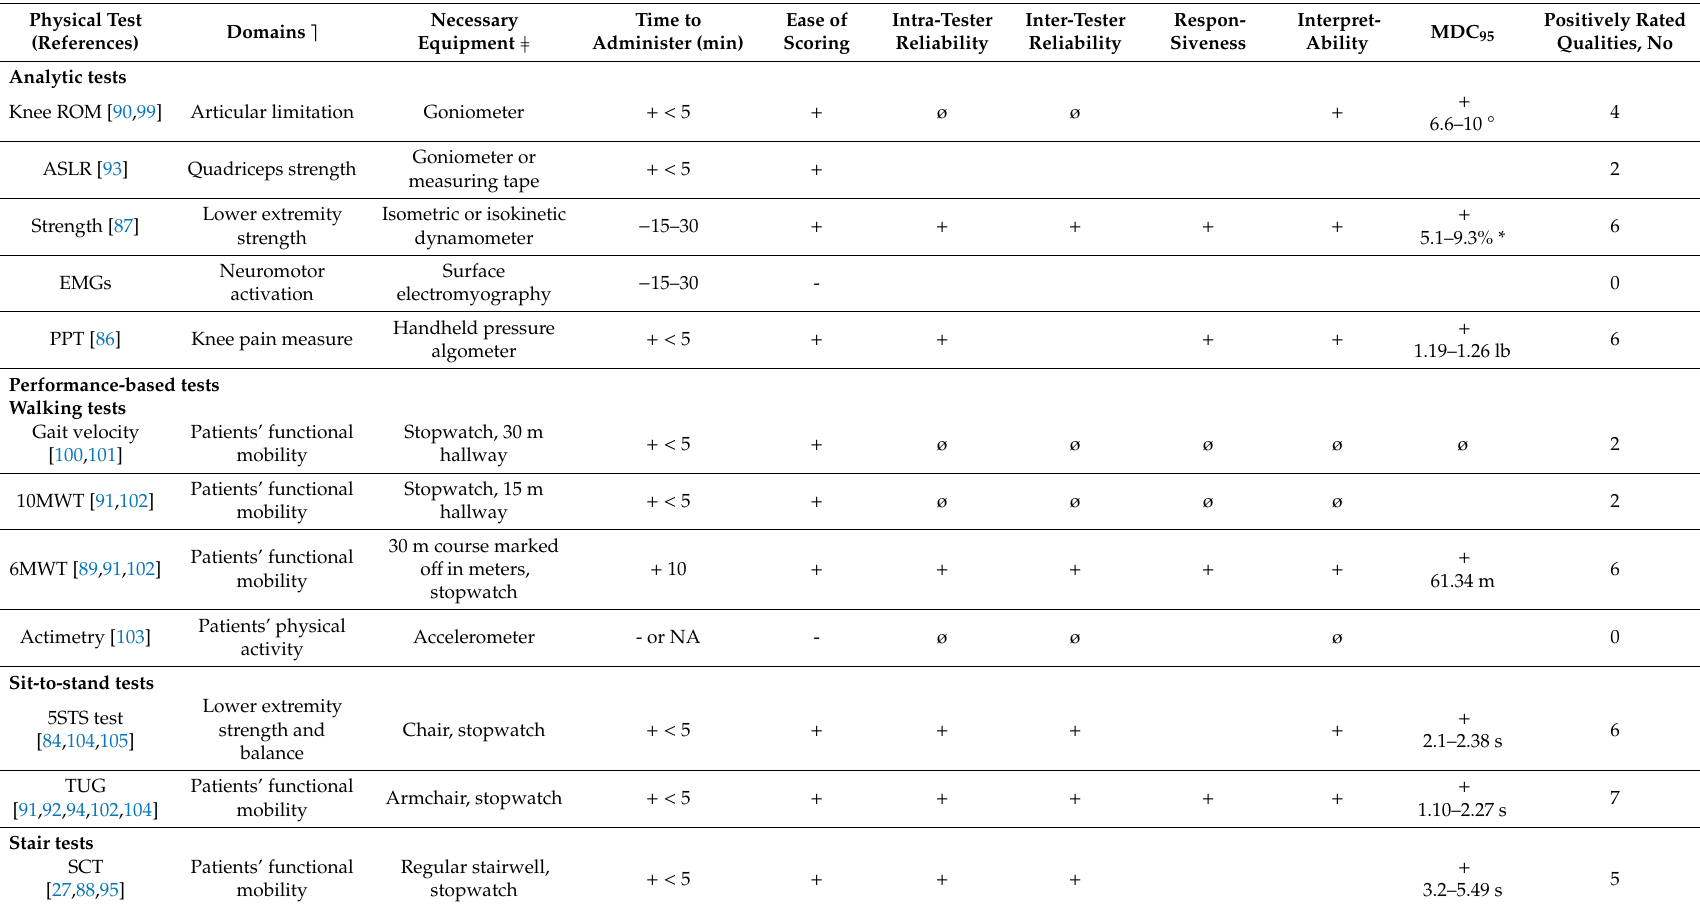
Table A5. Summary of the quality assessment of the included physical